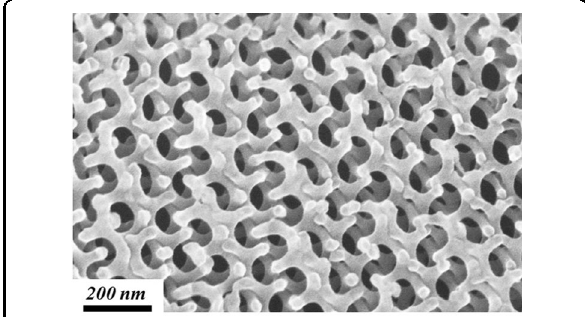
Fig. 3 Morphological characterization of the fabricated sample. FESEM micrograph of the gyroid-structured chitosan nanonetworks after removal of the PS template by using styrene